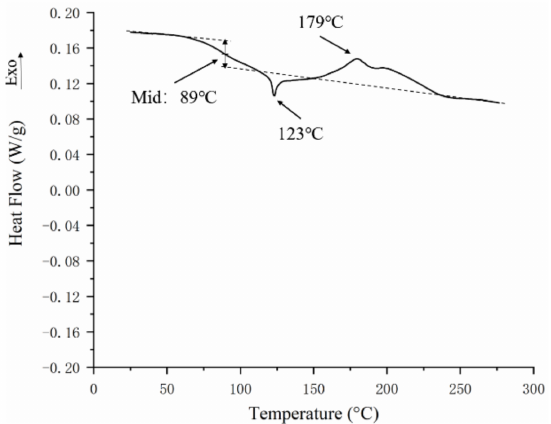
Figure 6. Heating DSC curves for silicone molding compound.